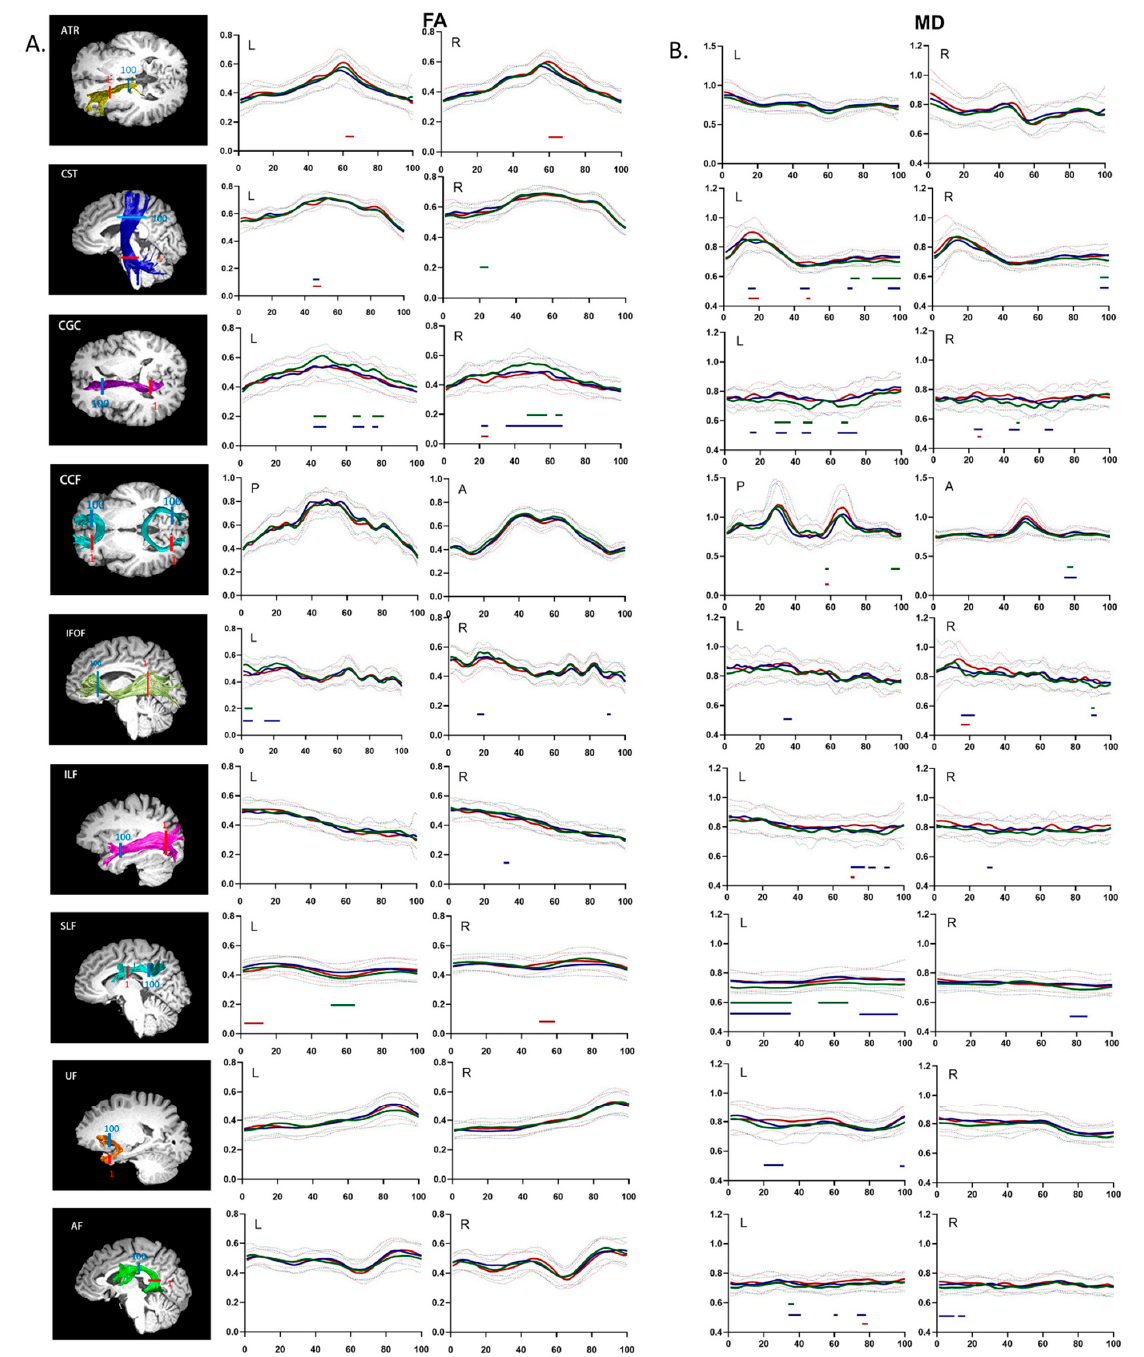
Figure 1. Pointwise comparison of ( A ) fractional anisotropy (FA) and ( B ) mean diffusivity (MD) profiles among the HZ, PHN, and HC groups. Notes: The renderings of significantly altered tracts are presented on the T1-weighted images on the left. Red: starting ROIs; blue: ending ROIs. The FA and MD profiles of 20 identified fiber tracts from HZ patients, PHN patients, and HCs (blue, red, and green, respectively) are presented as the mean (SD) (solid line and dotted line, respectively). The color bars under the FA or MD profiles indicate the regions of significant differences between the HZ and HC groups (green), the PHN and HC groups (blue), and the HZ and PHN groups (red). The Y -axis represents the FA or MD values. The X -axis represents the location between the starting and ending waypoint ROIs. Abbreviations: P, posterior; A, anterior; L, left; R,